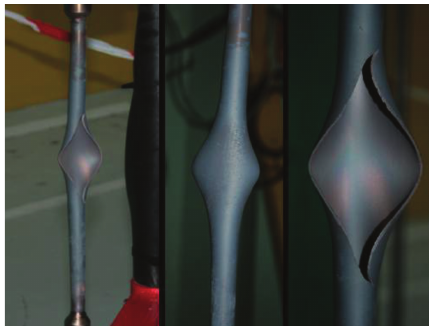
Figure 8: View of the tube after the SQUAT 3 test.